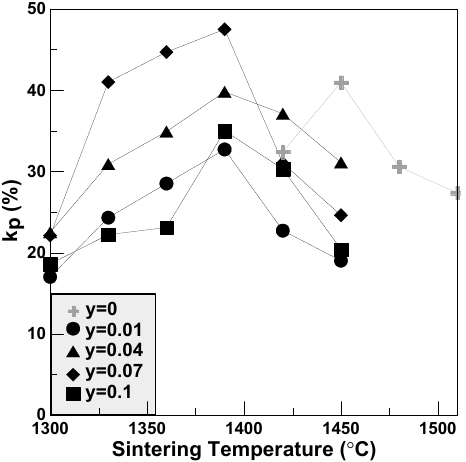
Figure 7. The electromechanical coupling factors of the BCTS–yLiF sheets.